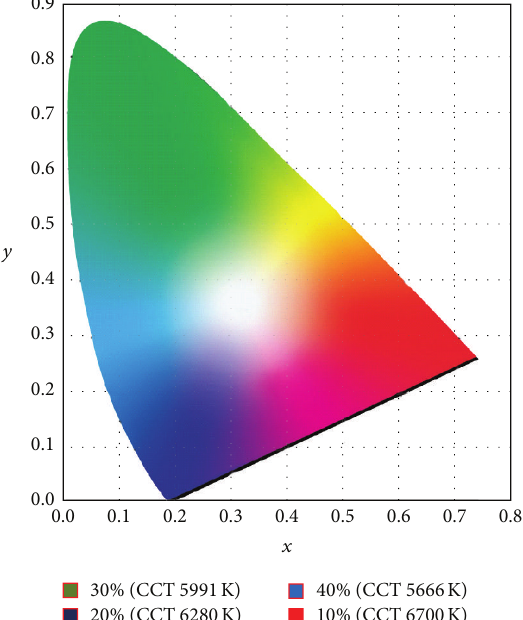
Figure 6: Chromaticity coordinates of the GaN-based LEDs on the YAG-PDMS